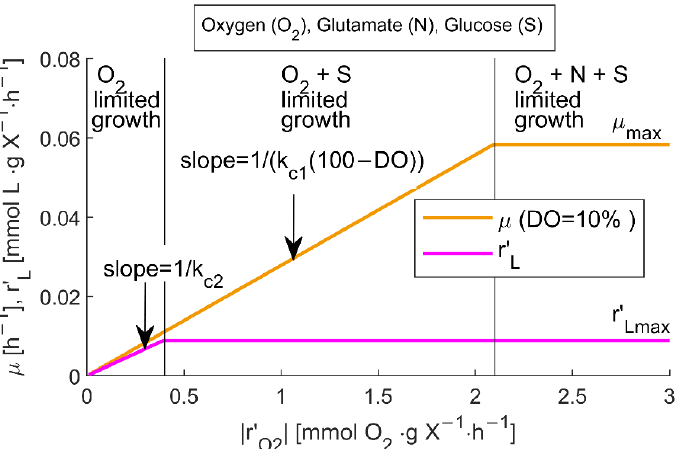
Figure 2. Simplified relation between specific oxygen uptake rate |r’ O2 |, the specific growth rate of active lipid-free biomass (µ), and the specific rate of lipid synthesis ( r L′ ), following the insights from GEM, for describing the simultaneous growth of the active lipid-free biomass and lipid synthesis observed. Increases in |r’ O2 | lead to total biomass growth, which accounts for active lipid-free biomass and lipids, first limited by oxygen mass transfer, then by glucose uptake (S), and finally, glucose and nitrogen (N) uptake.